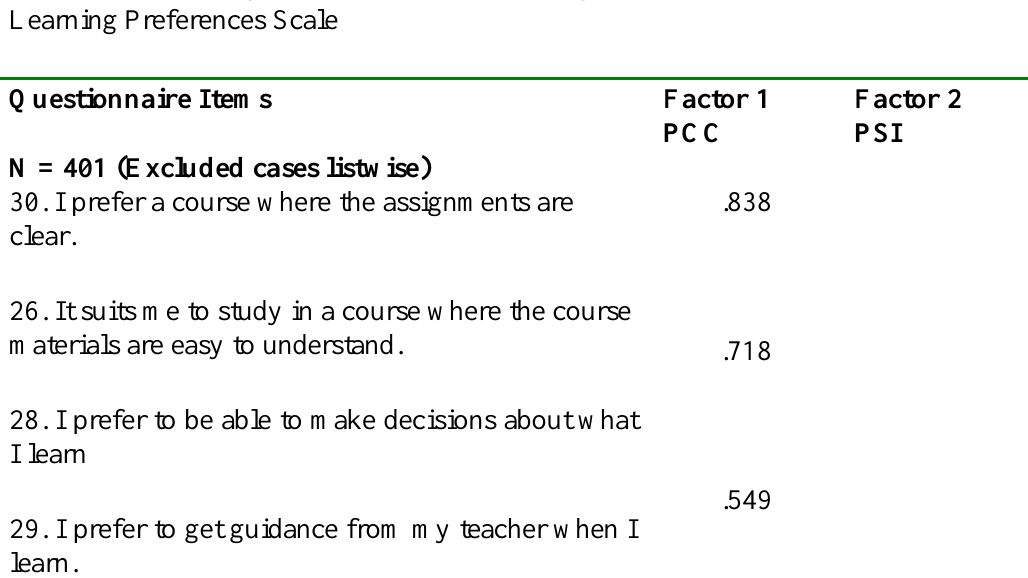
Table A2. Obliquely rotated component loadings of the items in the General Learning Preferences